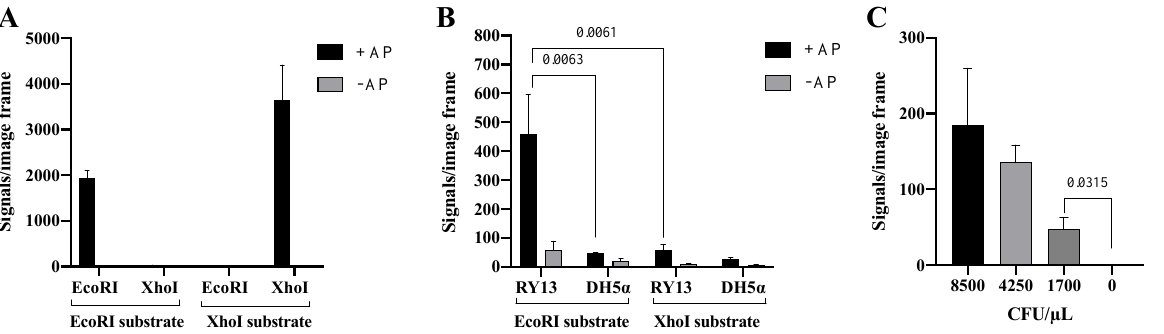
Figure 5. Cre assisted RE detection. ( A ) Purified EcoRI and XhoI on EcoRI and XhoI DNA substrates with alkaline phosphatase (+AP, black bar) and without alkaline phosphatase ( − AP, gray bar) to remove the 5′ -phosphate group before Cre assisted circularization of the substrate. ( B ) Extract from RY13 and DH5 α on both EcoRI and XhoI DNA substrates with AP (+AP, black bar) or without AP ( − AP, gray bar). ( C ) Titration of 8500 – 1700 CFU/ μ L RY13 E. coli on the EcoRI DNA substrate. All data are plotted as mean of signals/image frame with standard deviation, n = 3. p -values indicating significant difference as calculated with an unpaired t-test are marked in the graphs.